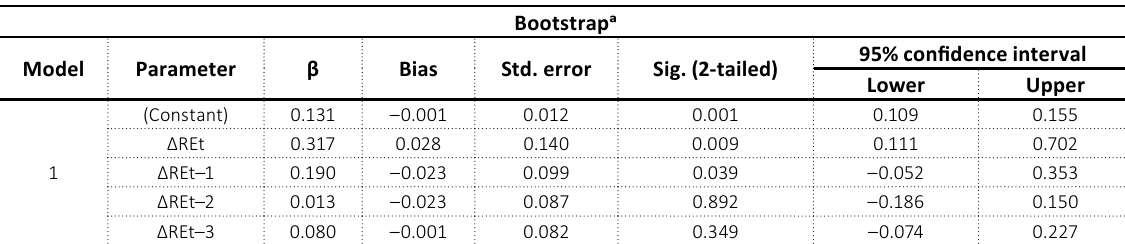
Table 5. CEO and Director cash pay to ROE